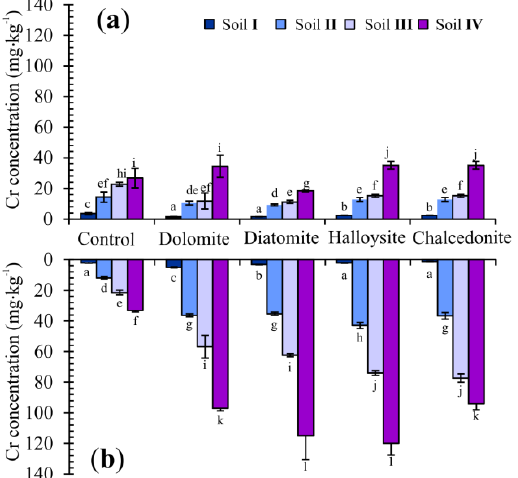
Figure 5. Chromium concentration (mg·kg −1 , dry weight basis) in the above-ground part ( a ) and roots ( b ) of Indian mustard at the end of the trial. Error bars are ± standard error ( n = 3). Bars marked with different letters differ significantly for the same Cr exposure ( p < 0.05) according to the Duncan test.